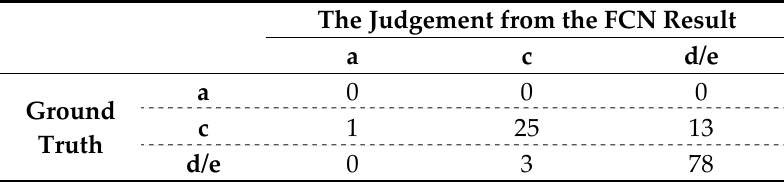
Figure 3. A part of the validation result by FCN. Table 2. The confusion matrix between the ground truth and the judgement from the FCN